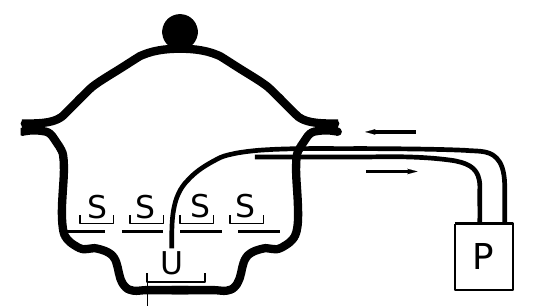
Figure 1. Experimental set-up with a desiccator vessel as the equi- libration chamber. P: recycling pump ensuring air mixing and air movement within the chamber, U: unconfined water filled in the bottom part of the chamber, S: samples placed on top of the per- forated middle plate. The arrows indicate the direction of air flow. Vaseline was used as sealant between the lid and the